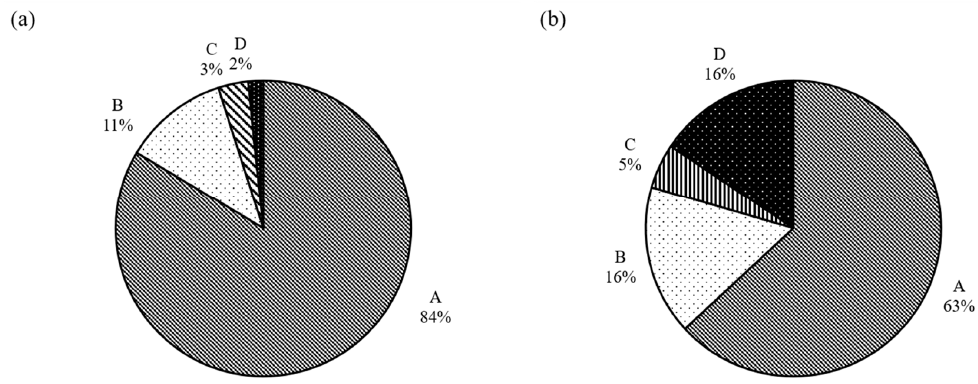
Figure 20. Distribution of the different classes of load–displacement curves for different loading rates: ( a ) 0.01 mm/min; ( b ) 1 mm/min.